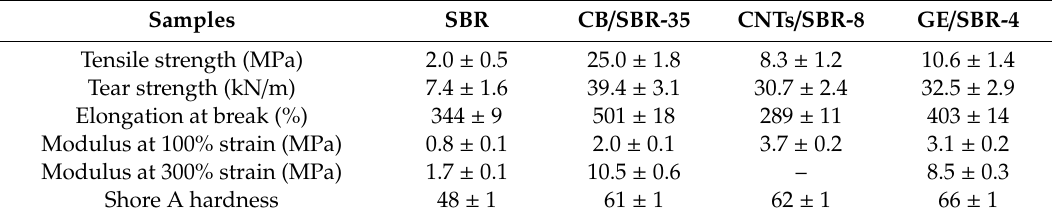
Figure 7. Strain-stress curves of SBR composites filled with different contents of ( a ) CB; ( b ) CNTs and ( c ) GE; ( d ) strain-stress curves of CB/SBR-35, CNTs/SBR-8 and GE/SBR-4 composites. Table 1. The mechanical properties of pure SBR, CB/SBR-35, CNTs/SBR-8, and GE/SBR-4